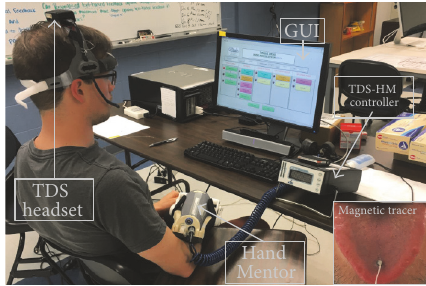
Figure 1: Experimental set-up. Top center, the graphical user interface (GUI) that participants view during game training. Bottom center, the Hand Mentor (HM) device worn on the right (paretic) upper extremity. Left, healthy volunteer with TDS headset affixed to the head. Magnetic sensors are positioned bilaterally to capture the maximal oral area. Bottom right, the small magnetic tracer used to control the HM device. Bottom center, the HM controller with red safety button to be used to immediately stop the